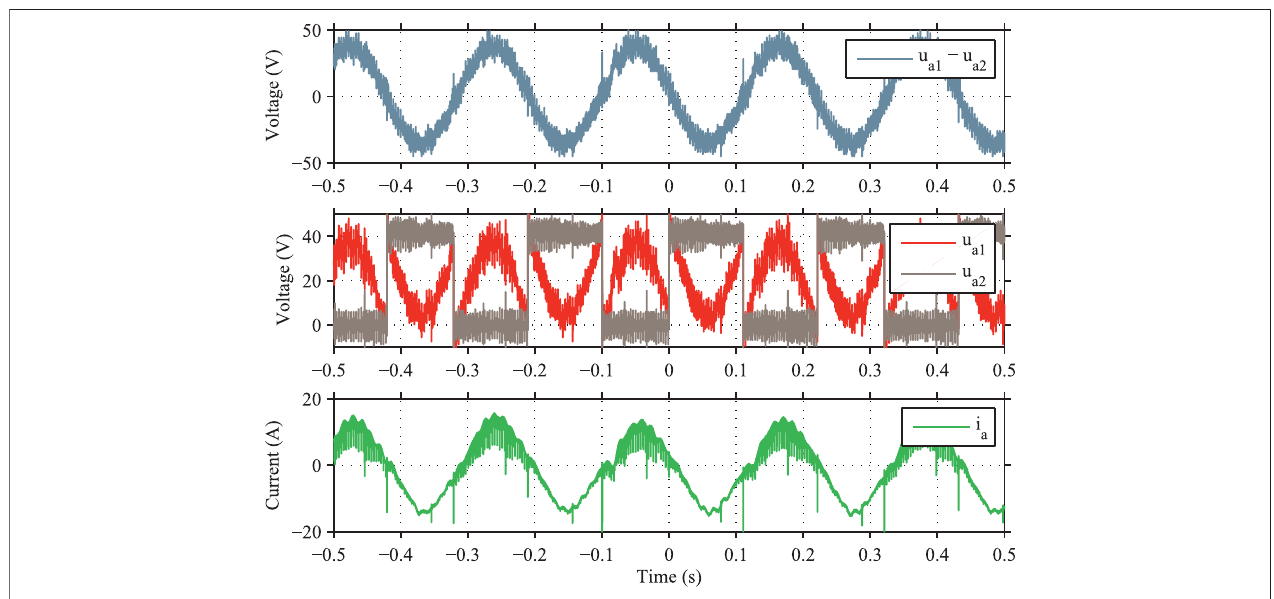
FIGURE 10 | Output voltage and current measurement of the novel high-speed turbo compressor system with integrated inverter.